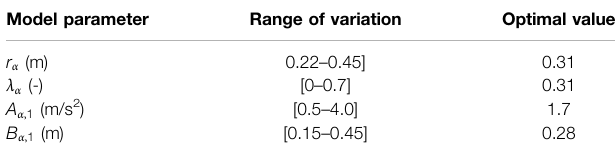
TABLE 2 | Ranges of variation and optimal values of the updating parameters. Model parameter